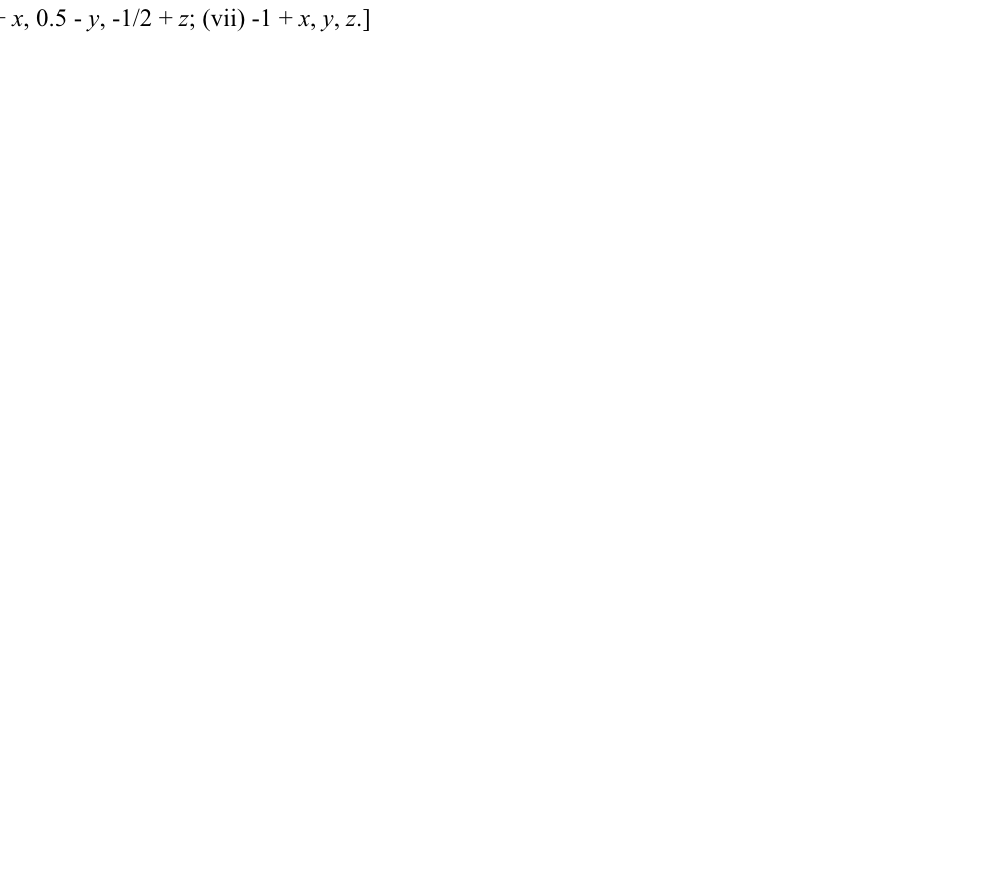
YbP O Displacement ellipsoids are drawn at the 50% probability level. [Symmetry codes: (i) Part of the structure of NH 4 2 7. 1 - x ,-1/2 + y , 1.5 - z ; (ii) x , 0.5 - y , -1/2 + z ; (iii) x , 0.5 - y , 1/2 + z ; (iv) 2 - x , -1/2 + y , 1.5 - z ; (v) 1 - x , 1 - y , 1 - z ; (vi} -1 + x , 0.5 - y , -1/2 + z ; (vii) -1 + x , y , z